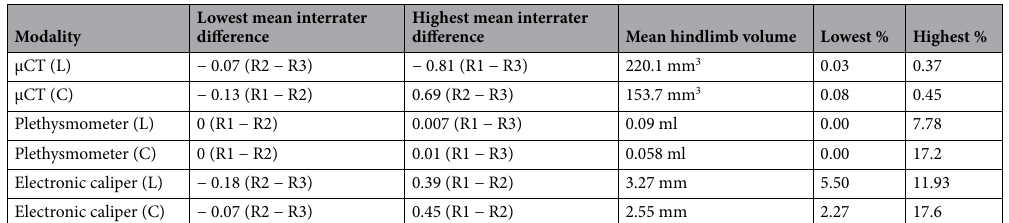
Table 5. Table comparing the lowest and highest interrater differences, mean hindlimb measurements and the percentage between the two across all three modalities. L lymphedema hindlimb, C control hindlimb, CT computed tomography, μ micro.